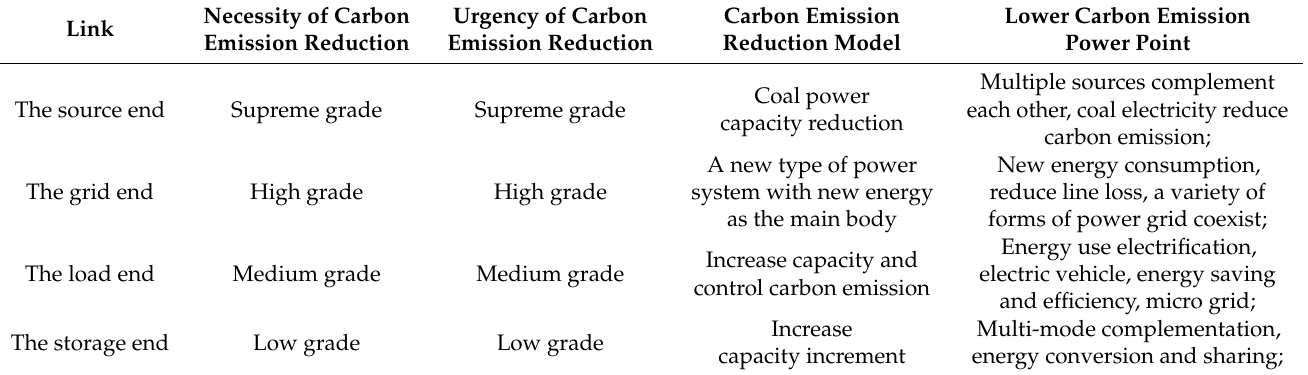
Table 1. Characteristic table of carbon reduction and emission reduction in each link of the Energy